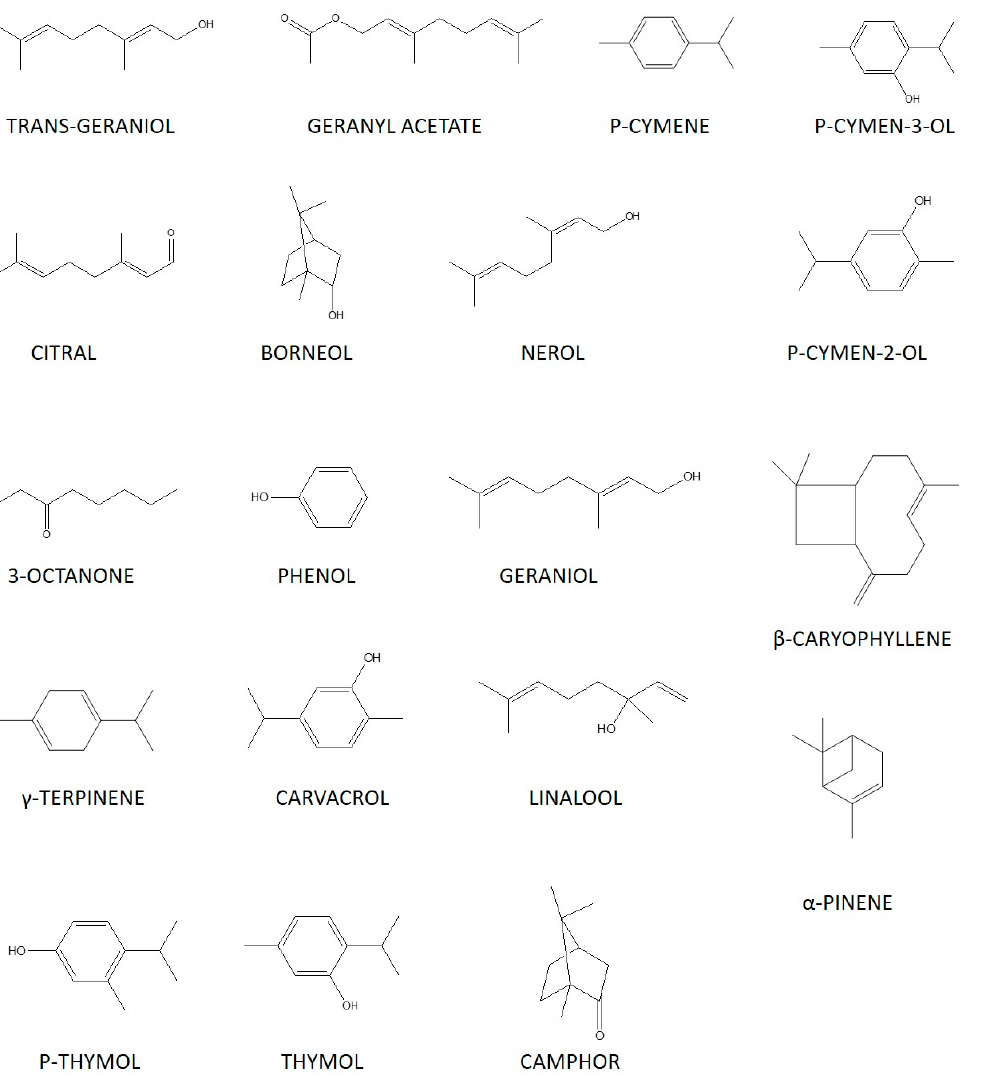
Figure 2. The chemical structure of certain important components in the essential oil of T. quinquecostatus .